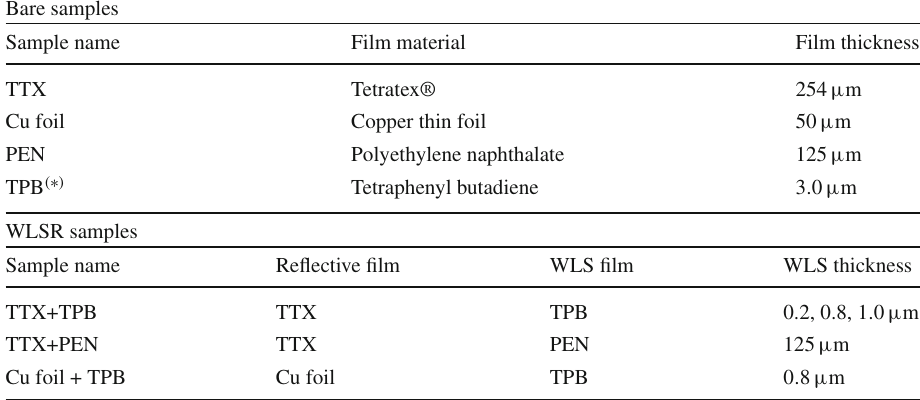
Table 1 Samples measured